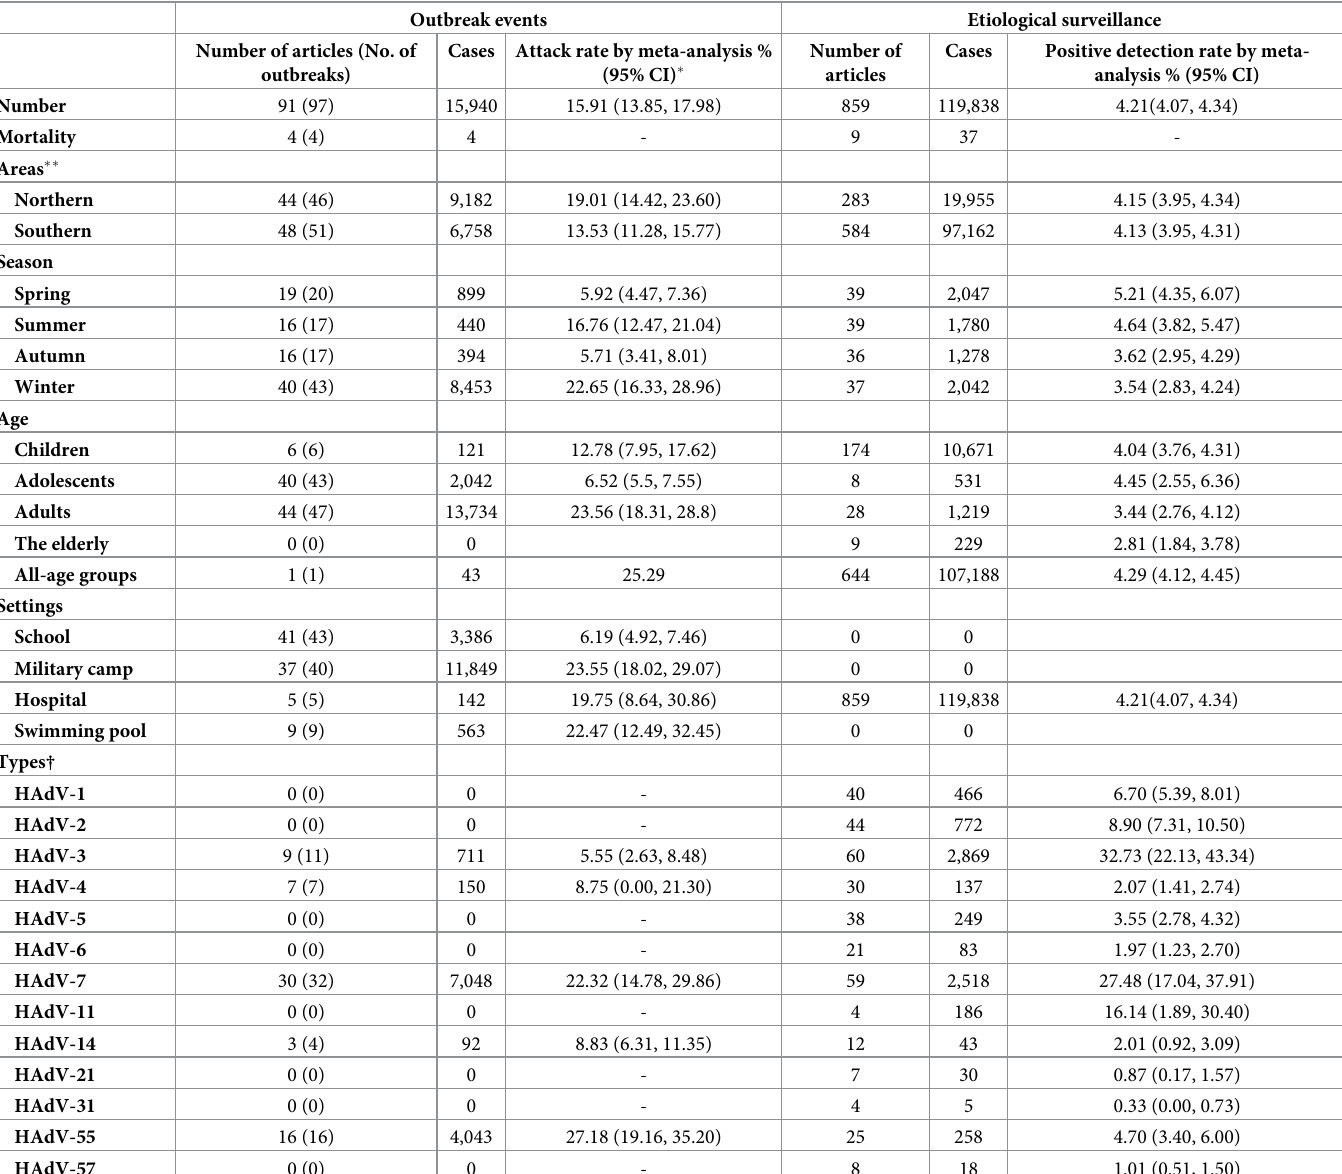
Table 1. Attack rate and positive detection rate of HAdV by areas, seasons, patients’ ages, settings and virus types based on